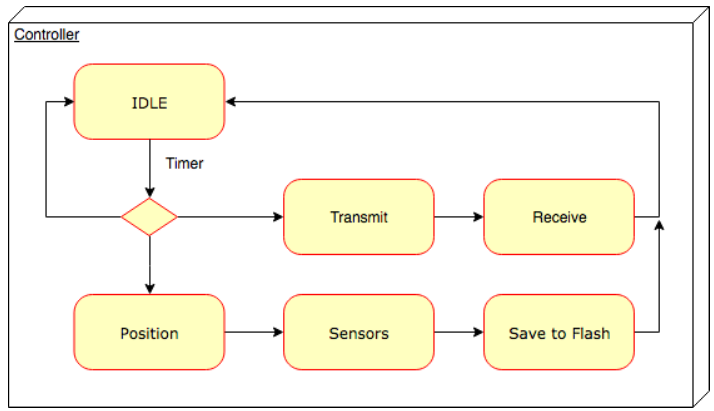
Figure 12. Simplified Finite State Machine of the controller. Table 1. Average power